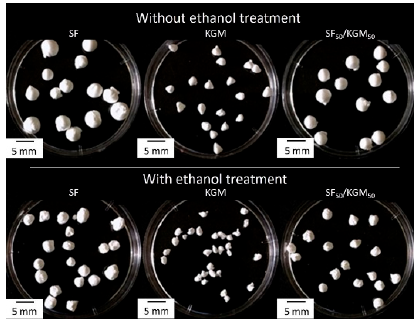
Figure 2. Images of the synthesized beads.